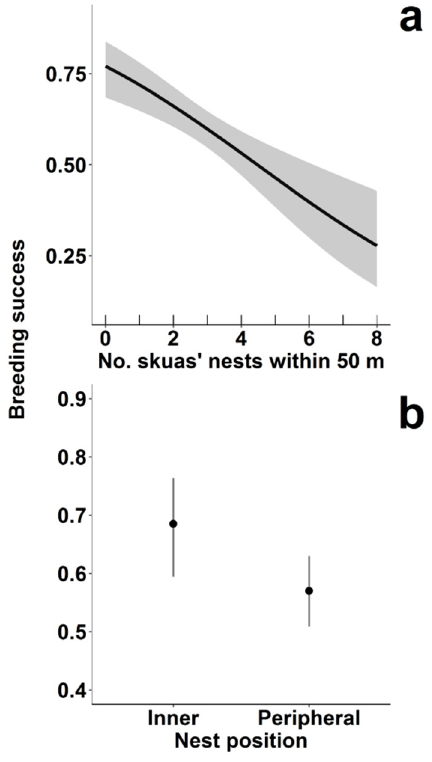
Figure 7. Effects of ( a ) number of skua nests within 50 m and ( b ) nest position on the breeding success of Adélie penguins predicted by GLMs. In ( a ), marks along the x -axis show the distribution of observed values. Black lines or dots: predicted values. Grey bands or bars: 95% confidence inter- vals.